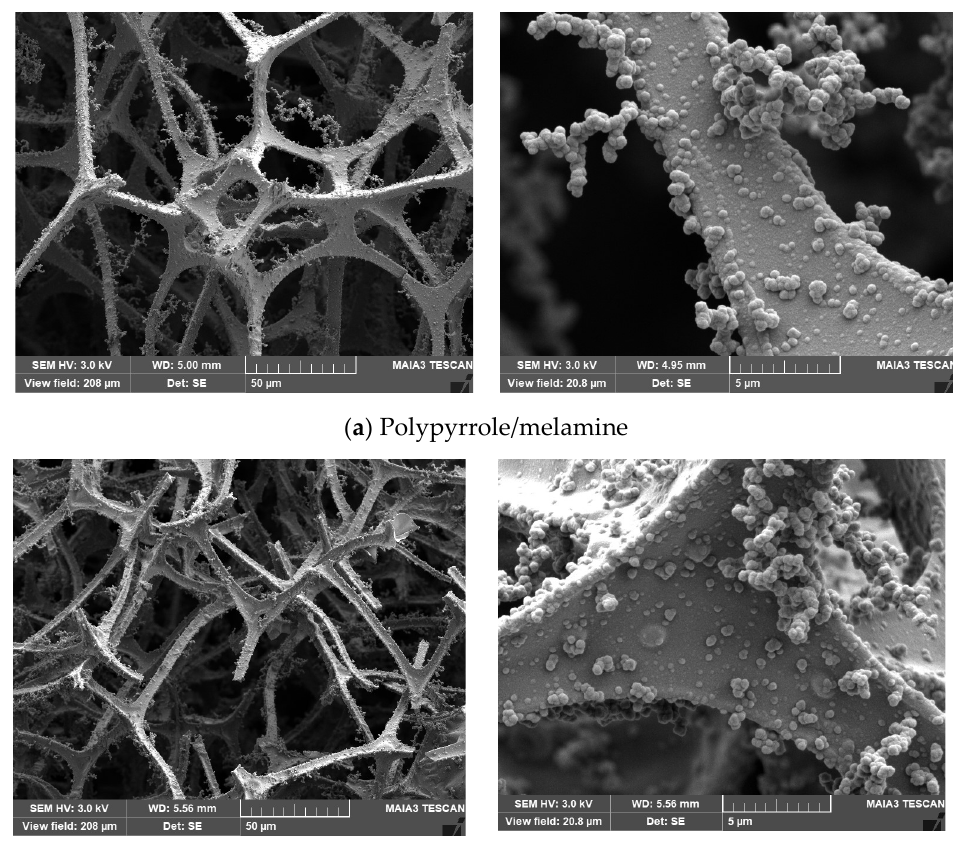
Figure 4. Micrographs of polypyrrole-coated melamine sponge ( a ) before, and ( b ) after carbonization at 650 °C taken at lower ( left ) and higher magnification ( right ).